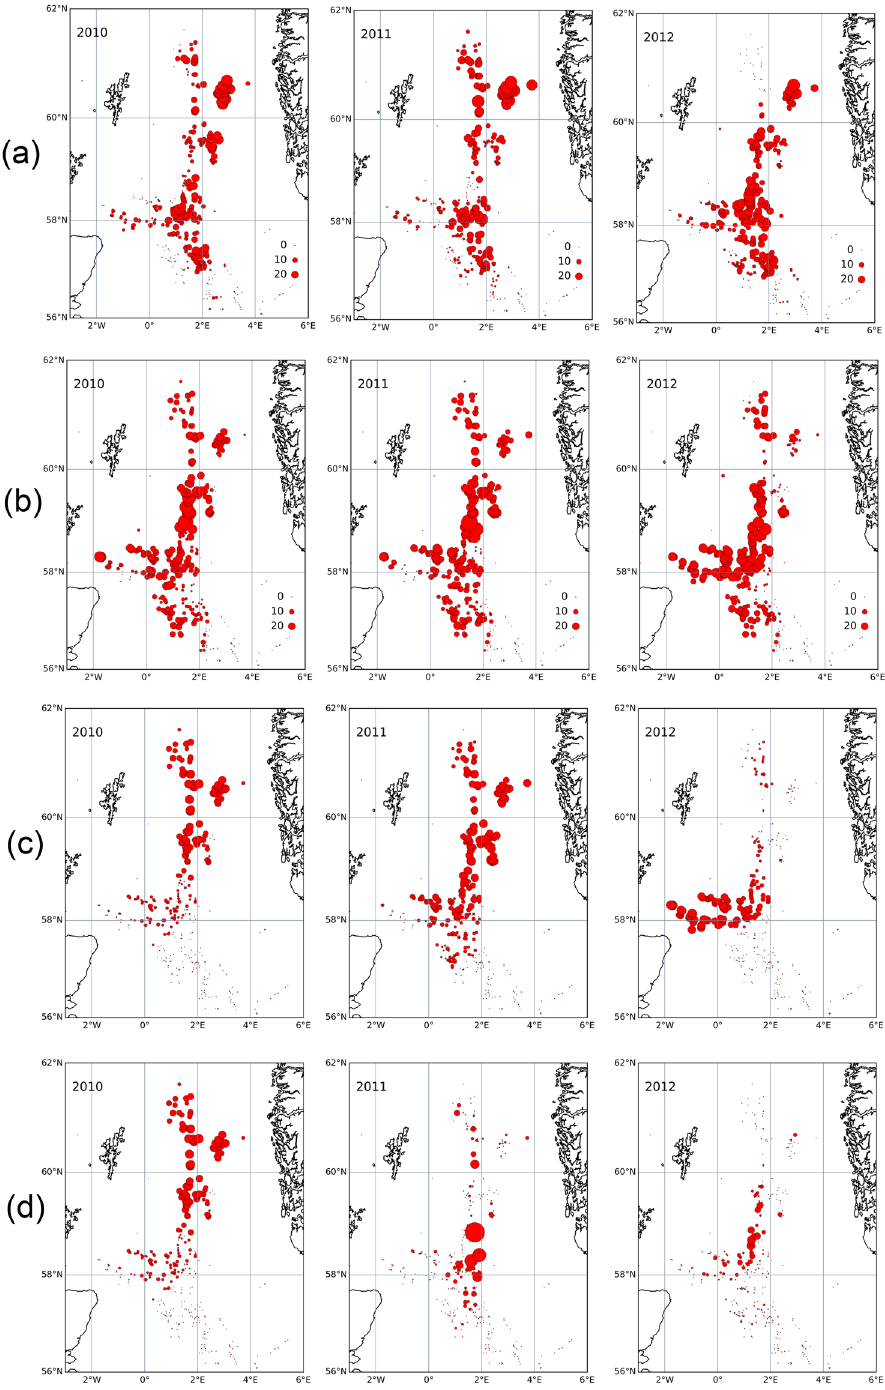
Figure 3. Network metrics including ( a ) in-degree, ( b ) out-degree, ( c ) log-scaled eigenvector centrality, and ( d ) betweenness for the putative system of Lophelia pertusa populations on oil and gas installations in the North Sea spanning a strong negative (2010) to positive NAO state (2012). Circle size indicates the magnitude of the metric. For simplicity, structures that do not connect to any other structures are not